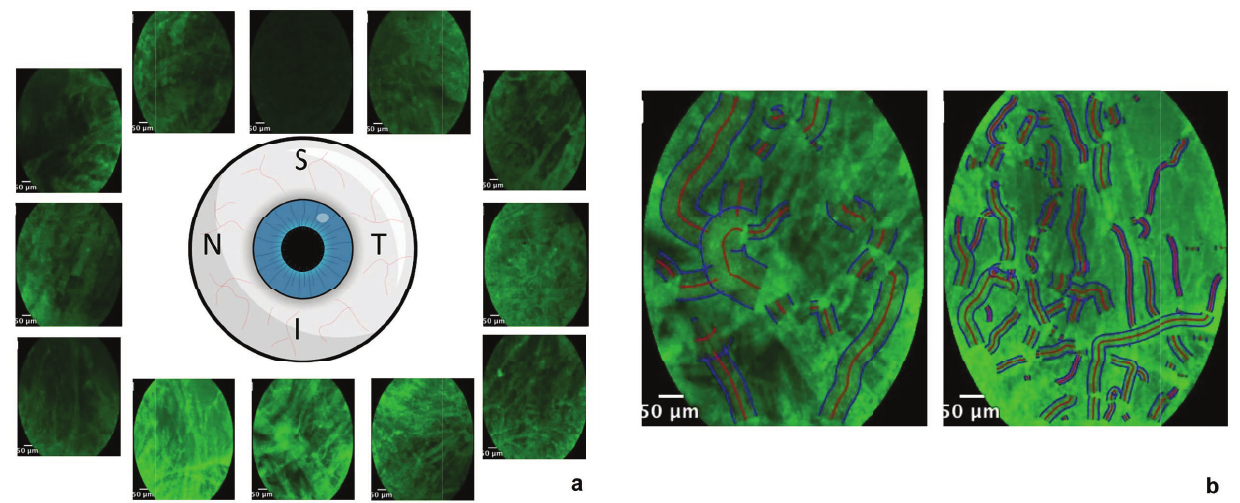
Figure 5. Distribution of fluorescence signal along the limbal perimeter. Representative frames from individual quadrants were chosen to highlight the differences in fluorescence signals along the limbus (a). The differences can be quantified using a vessel segmentation algorithm, which automatically detects the vessel border and midline (b) and quantifies vessel diameter and signal intensity in the chosen region of interest.